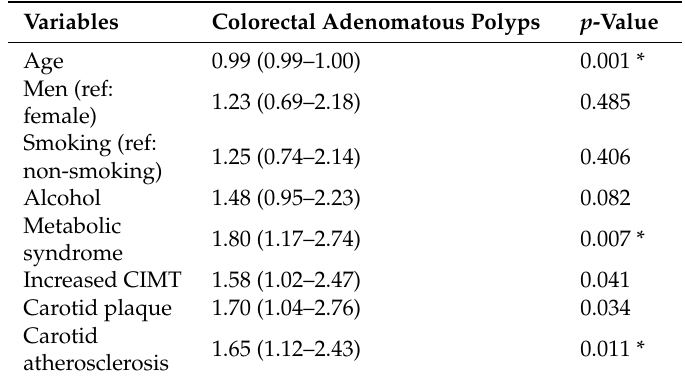
Table 3. Adjusted odds ratios (95% confidence intervals) for colorectal adenomatous polyps using multivariate